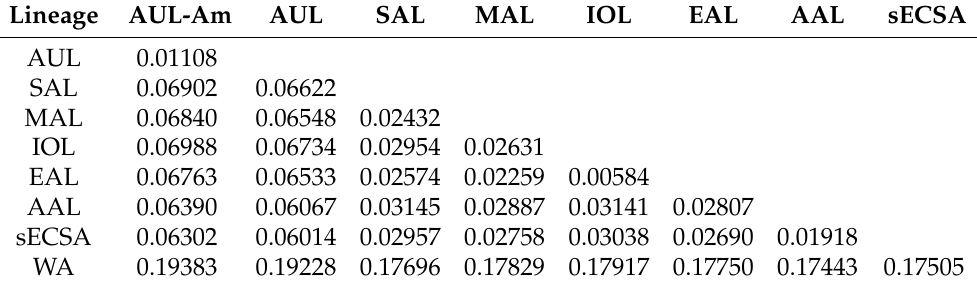
Table 1. Estimates of evolutionary divergence over sequence pairs between Chikungunya virus (CHIKV) lineages. The number of base substitutions per site from averaging over all sequence pairs between groups are shown. Analyses were conducted using the Maximum Composite Likelihood model [52] with 924 CHIKV nucleotide sequences encompassing the lineages/groups observed in this study. Lineages: Asian urban (AUL), AUL-America (AUL-Am), South America (SAL), Middle Africa (MAL), Indian Ocean (IOL), East Africa (EAL), Africa and Asia (AAL), Sister Taxa to ECSA (sECSA), West Africa